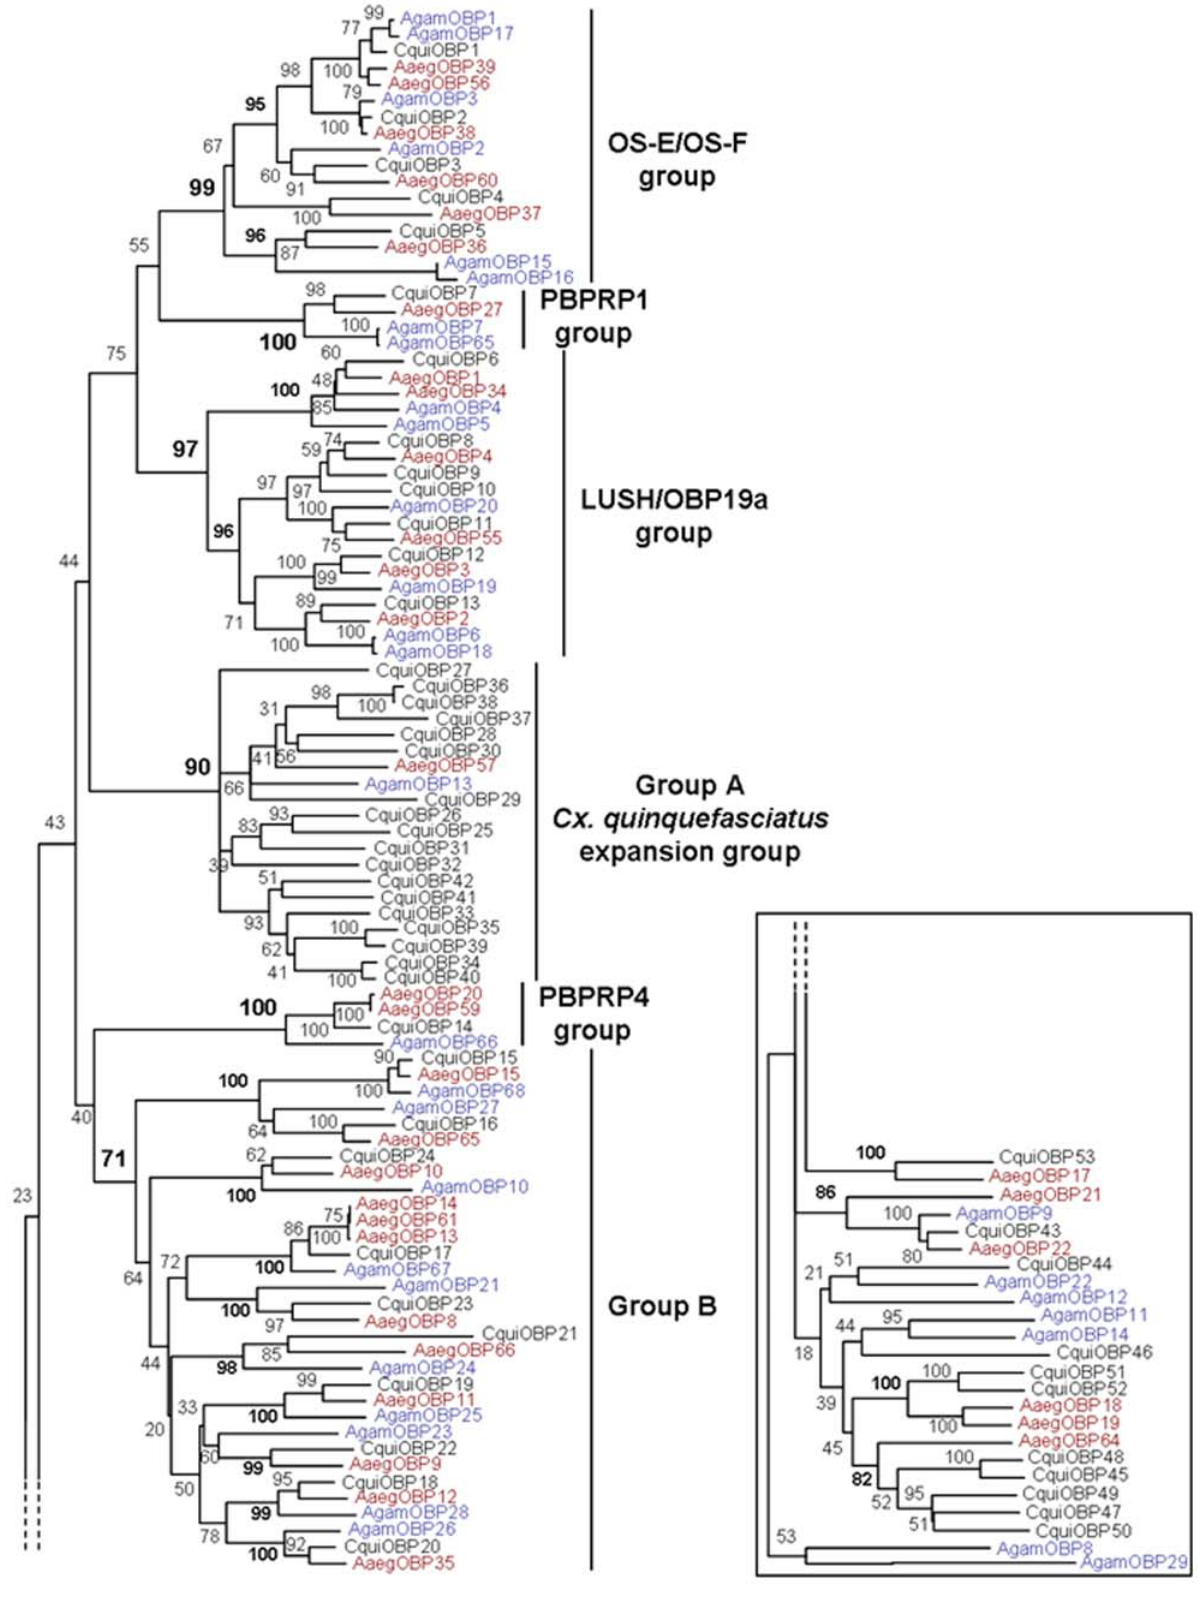
Figure 2. Phylogenetic relationships of mosquito ‘‘classic’’ OBPs. The unrooted consensus tree was generated with 1000 bootstrap replicates using the neighbor joining method. Cx. quinquefasciatus OBPs are in black, A. gambiae OBPs are in blue and A. aegypti OBPs are in red. A. gambiae and A. aegypti OBPs follow the nomenclature established in [21] and [23]. Robust groupings identified by high bootstrap values at nodes are indicated in bold.